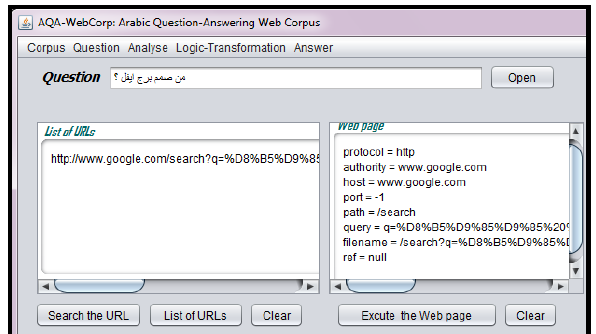
Figure 5. List of URLs generated for the question " !"# $%& '( !"#$ ! ".